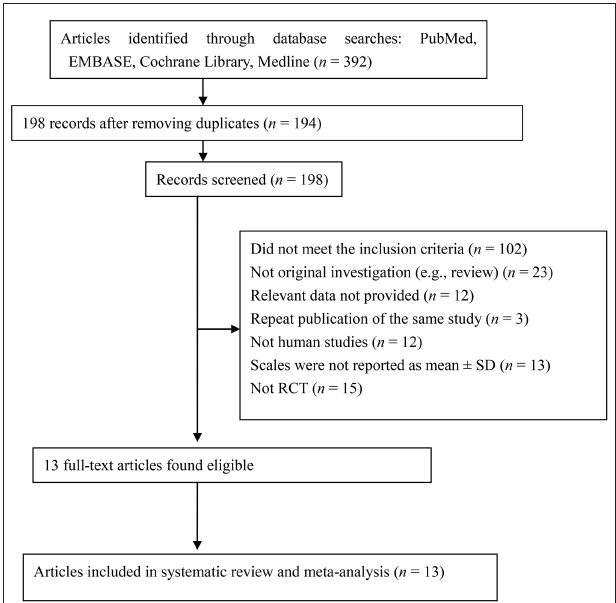
FIGURE 1 | PRISMA flow diagram of articles included in the